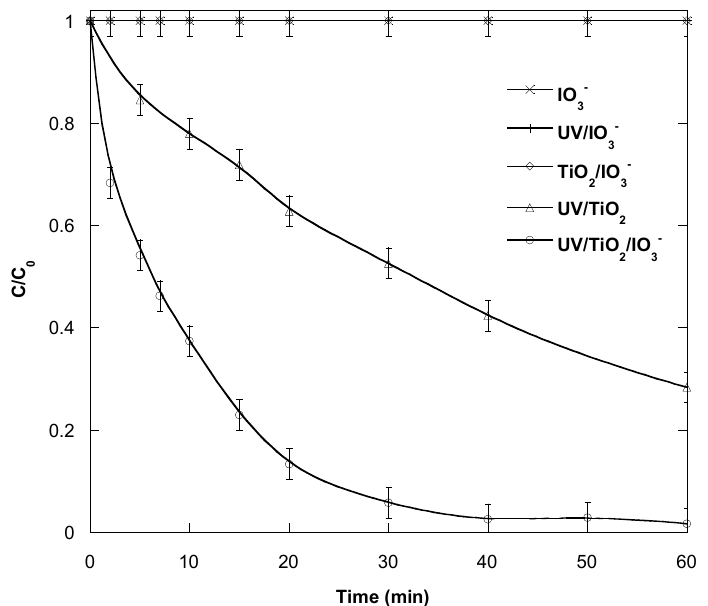
Figure 1. Effect of iodate on SO degradation in different systems ([IO 3 − ] = 0.15 mM, [TiO 2 ] = 0.4 g · L − 1 , [SO] = 10 mg · L − 1 , T = 25 ± 2 ◦ C and pH~6).